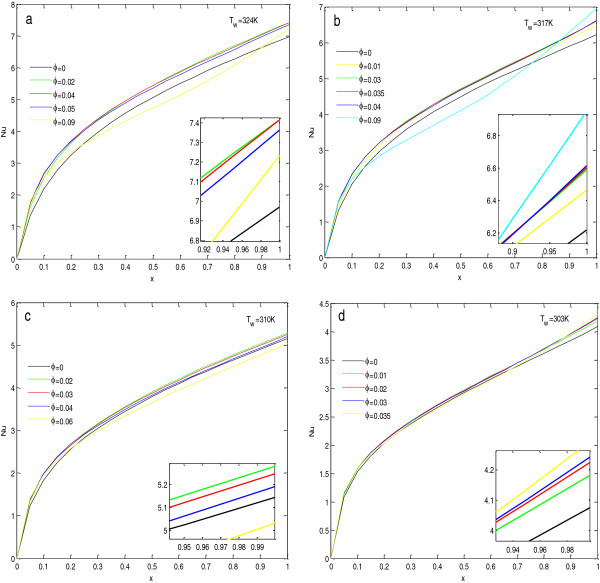
Local Nusselt numbers for Al2O3 + H2O nanofluid at(a,b,c,d)different wall temperatures.